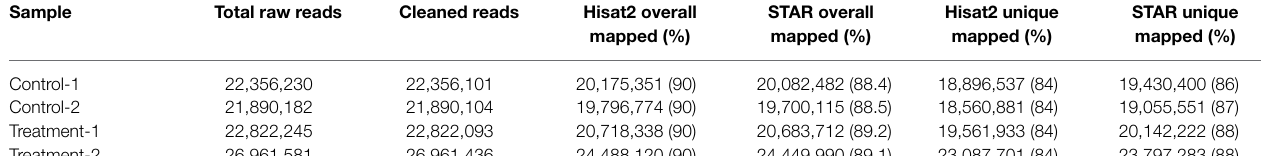
TABLE 1 | Different statistics of sequence quality and mapping rate for four samples of the M. grisea transcriptome. Sample Total raw reads Cleaned reads Hisat2 overall